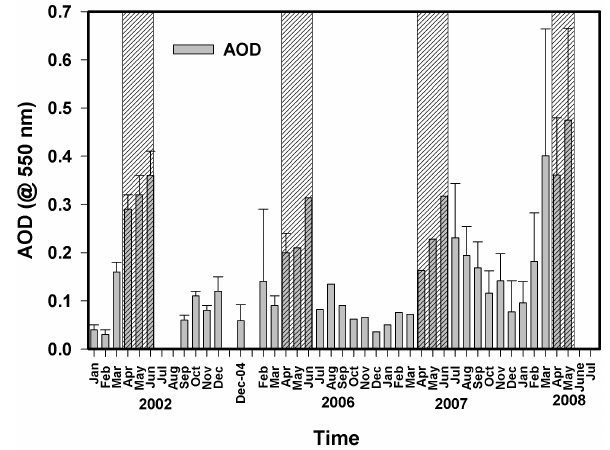
Fig. 6. The monthly mean aerosol optical depth (AOD @ 550nm) at Manora Peak. The AOD data for the years 2002 and Dec 2004 are taken from Sagar et al. (2004) and Pant et al. (2006), respectively. The vertical strips indicate the high AOD representing premonsoon season (April–June) of the respective